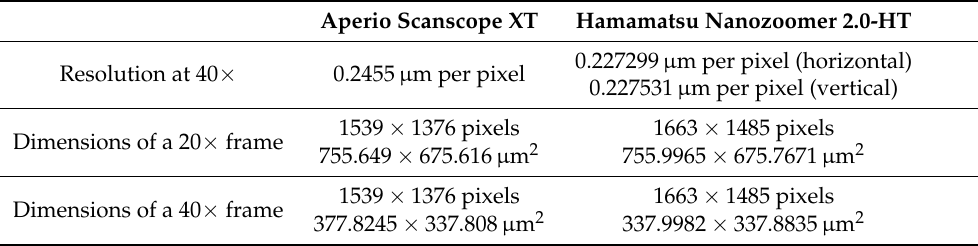
Table 1. Resolution of the scanners and dimensions of frames on the MITOS-ATYPIA